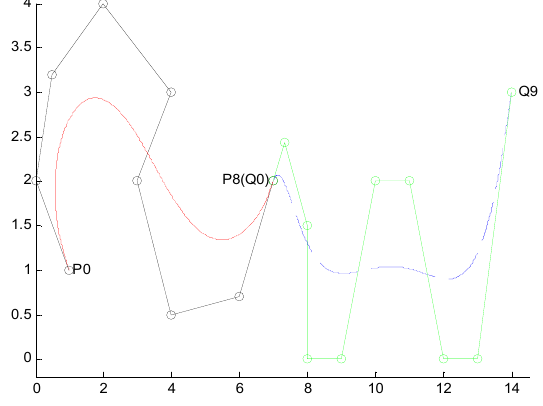
Figure 2. G 1 smooth continuity of two sextic S- λ curves.